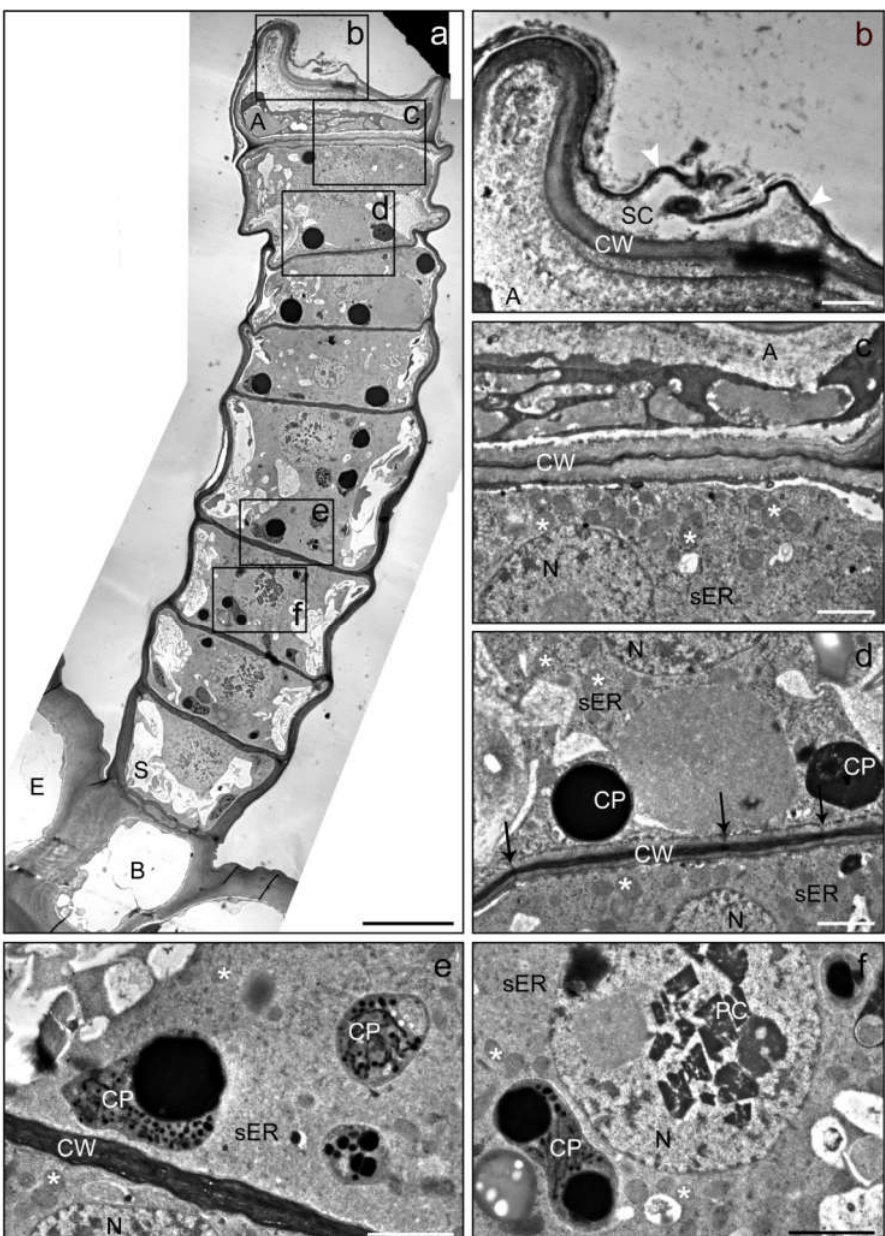
Figure 4. TEM images of a linear glandular trichome from a leaf vein in a late secretory stage. Frames in the overview ( a ) mark positions of the details ( b – f ). ( b ) The apical cell (A) showed strong degeneration and was partly collapsed; the subcuticular cacity (SC) between the cell wall (CW) and the cuticle (white arrowheads) seemed to have collapsed through rupture of the cuticle. ( c ) The cytosol of the apical cell (A) lacked clearly defined organelles, whereas the adjacent glandular cell was still vital and contained an intact nucleus (N), numerous mitochondria (stars) and smooth (sER) endoplasmic reticulum. ( d , e ) Glandular cells in the upper and central part of the trichome showing plastids (CP) with electron-dense inclusions and plasmodesmata (black arrows) in the periclinal cell wall (CW). ( f ) Glandular cell in the lower trichome region baring crystals (PC; presumably of proteins) in the nucleus. The number and volume of vacuoles increased towards the trichome base. Scale bar: 10 µm ( a )/1 µm ( b – f ); (E) epidermis cell, (B) basal cell, (S) stalk cell.